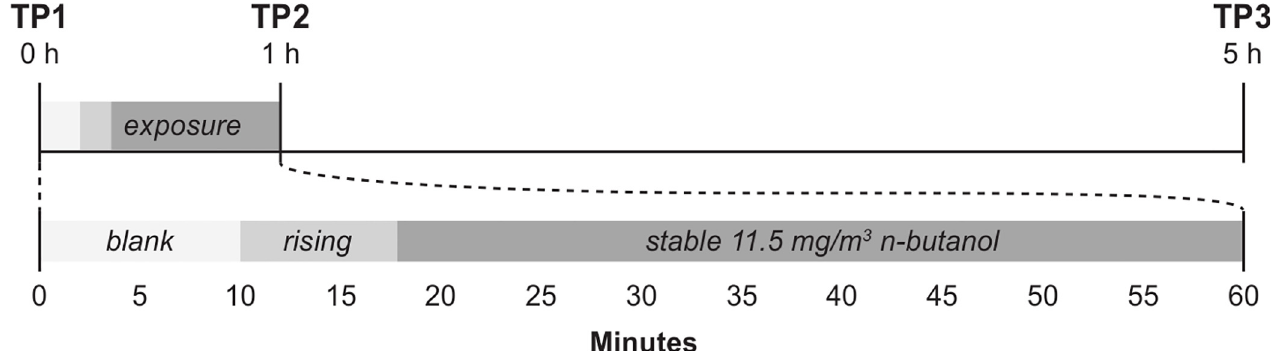
Fig 1. Overview of the exposure procedure and samples collection. During the first 10 min of testing, no odorant was delivered to the chamber, where after n- butanol was released into the chamber and reached its peak concentration about 8 min later. The concentration remained at this peak level (3.7 ppm) for the rest of the exposure session. Airway epithelial lining fluid was collected within 30 minutes prior to the exposure session (time point 1, TP1), within 15 minutes post exposure session (TP2) and again 4 hours after the exposure session was terminated